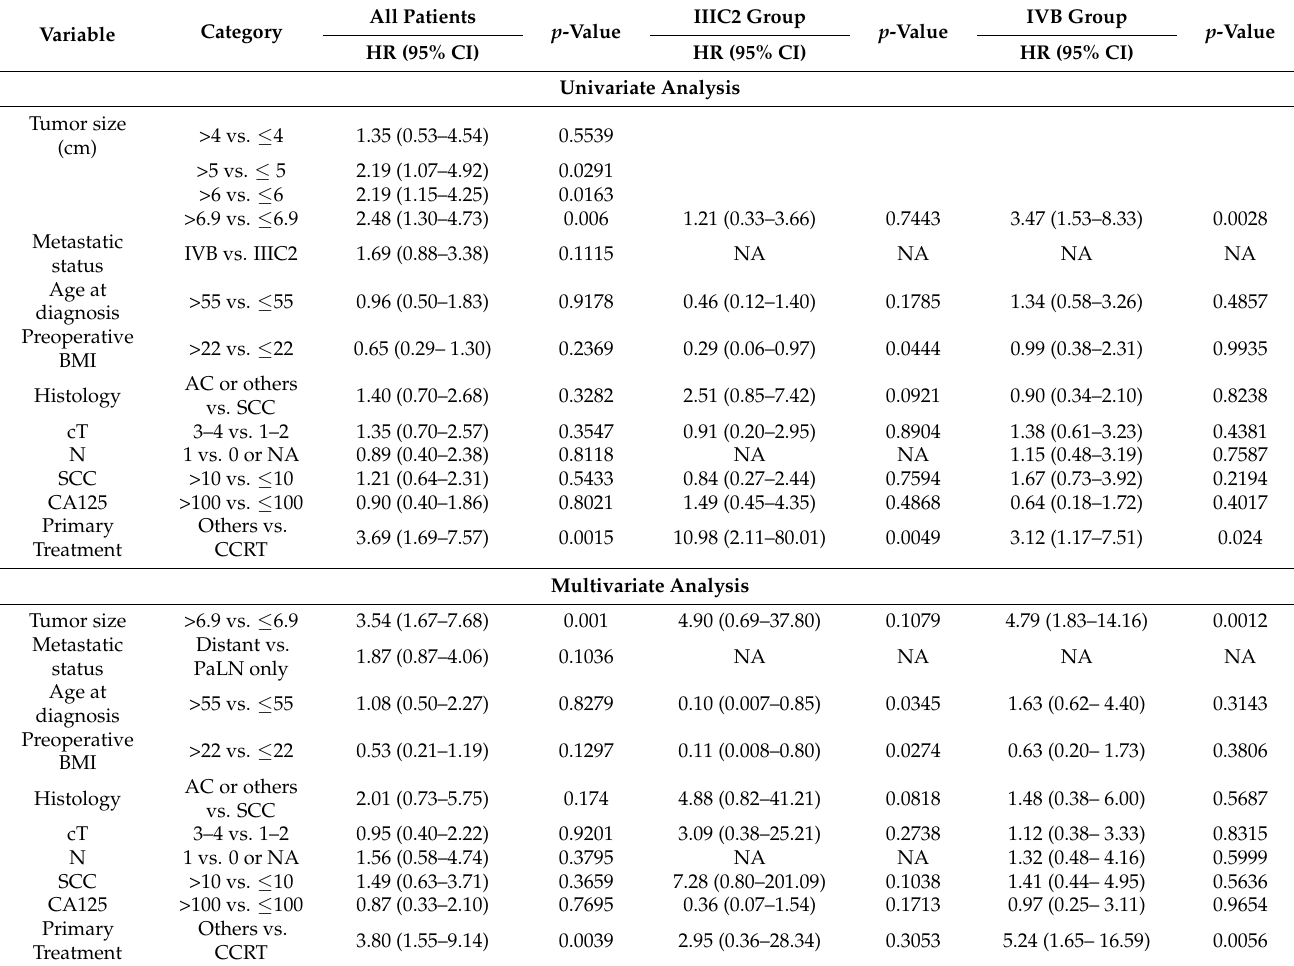
Table 3. Cox regression models for overall